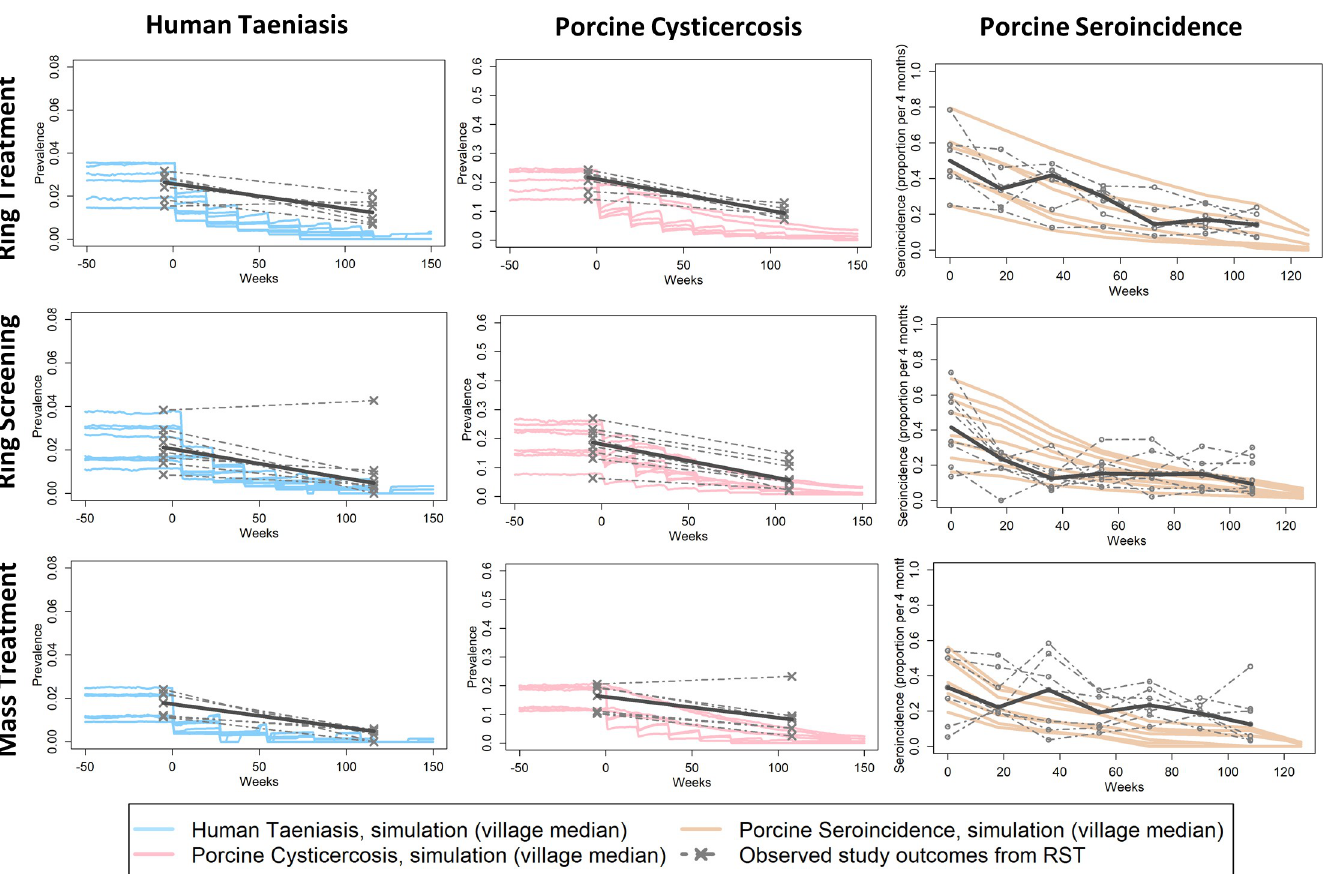
Fig 3. Simulation outcomes versus observed rates of human taeniasis, porcine cysticercosis and porcine seroincidence in the Ring Strategy Trial, by intervention type (n = 21 villages). Plots display village-specific median simulated outcomes in CystiAgent across 1000 simulations per village, and observed outcomes from RST (median value within intervention type in bold). For ring treatment (n = 6 villages), ring screening (n = 8 villages) and mass treatment (n = 7 villages villages), intervention and without pig treatment are combined. See S1 Fig for sub-arm comparisons of villages with and without the addition of pig